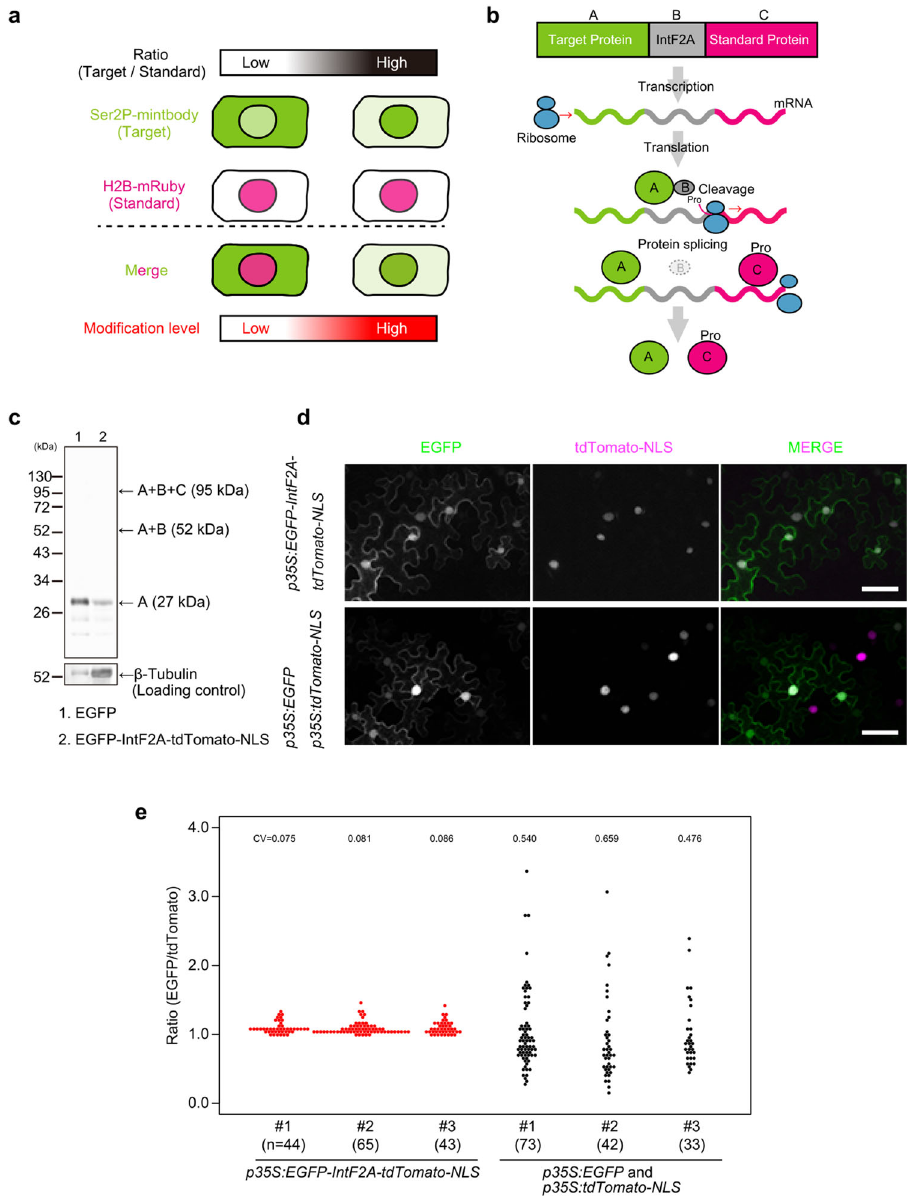
Fig. 2 Intein and 2A peptide-mediated co-expression for the two-component system. a Schematic diagram of the strategy of the two-component system. The target protein (Ser2P-mintbody) with a fl uorescence protein and the standard protein (H2B-mRuby) with another fl uorescence protein are co- expressed in cells of interest, and the ratio of fl uorescence intensity of the target protein to that of the standard protein in nuclei is measured. As Ser2P- mintbody transiently binds to Ser2P and freely passes through nuclear pores, the ratio should re fl ect the Ser2P modi fi cation level in each cell. b Schematic diagram of the IntF2A-based co-expression system. The expression cassette is assembled by connecting an upstream target protein (molecule A) and a downstream standard protein (molecule C) with the IntF2A auto-processing domain (molecule B). Co-translational cleavage via the 2A-peptide produces the target protein with a remnant IntF2A residue and the standard protein with a proline residue (Pro), and then post-translational auto-cleavage via intein releases the target protein. As a result, the target protein and the standard protein are co-translated from the single mRNA in the same proportion in all cells. c Ef fi cient auto-cleavage and release of the target protein in Nicotiana benthamiana . In western blotting analysis, the total protein extract was probed with anti-GFP antibody for detection of the released target protein. A + B + C, A + B, and A denote unprocessed protein, the target protein with IntF2A, and totally processed protein, respectively. β -tubulin was used as a loading control. For the full-length western blots see Supplementary Fig. 4. d Transient expression with the two-component system in N. benthamiana . Epidermal cells in leaves were observed 3 days after in fi ltration of p35S:EGFP-IntF2A- tdTomato-NLS or a set of p35S:EGFP and p35S:tdTomato-NLS . EGFP and tdTomato fl uorescence is green and magenta, respectively. Scale bars, 50 µ m. e Ratios of EGFP fl uorescence intensity relative to tdTomato fl uorescence intensity in N . benthamiana . The epidermal tissue in leaves was observed 3 days after in fi ltration of p35S:EGFP-IntF2A-tdTomato-NLS or a set of p35S:EGFP and p35S:tdTomato-NLS . Ratios were calculated from 33 to 73 cells in each leaf, and values are shown in dot plots. n = biologically independent cells. CV coef fi cient of variation. Source data underlying the plot are available as Supplementary Data